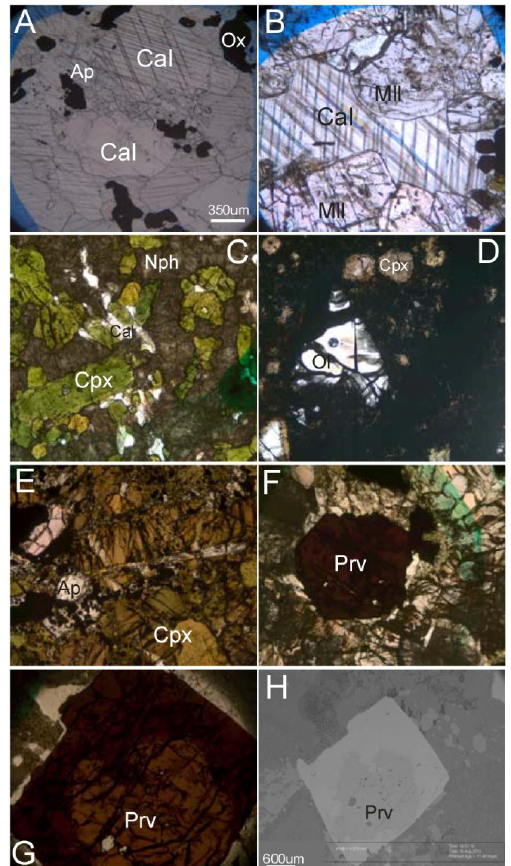
Figure 2. Petrographic images illustrating the mineralogy of the different rock types investigated here. ( A ) carbonatite- Oka51; ( B ) okaite- Oka138; ( C ) ijolite-